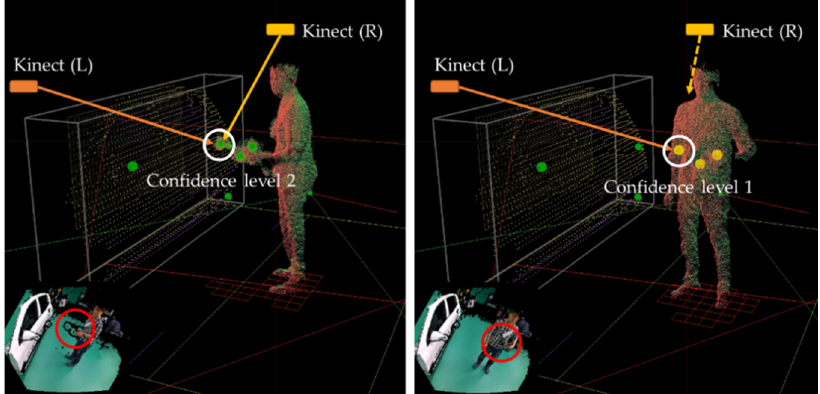
Figure 13. Examples of confidence levels based on marker positions (green circle: confidence level 2, yellow circle: confidence level 1).